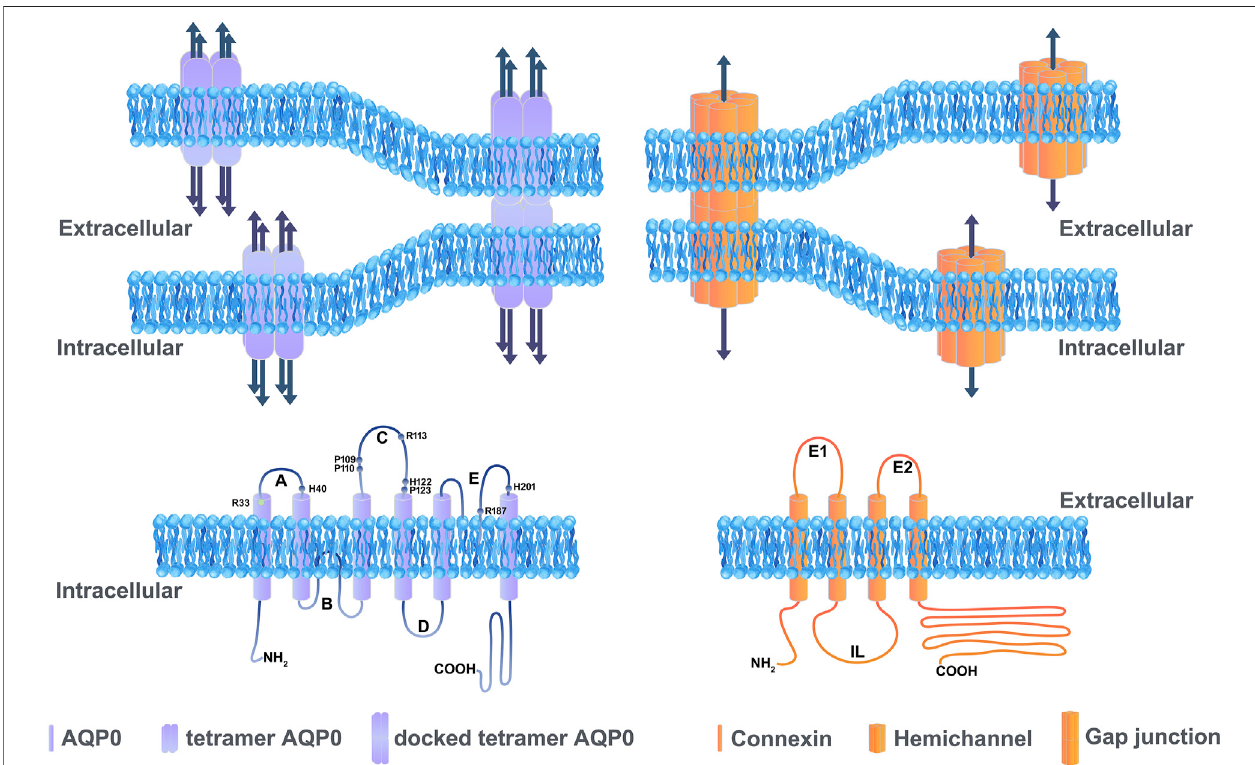
FIGURE 1 | Illustration showing the basic structure of channels formed by aquaporins and connexins. Aquaporins and connexins share similar membrane topologies consisting of transmembrane domains connected by extracellular and cytoplasmic loops; both the amino- and carboxy-termini are intracellular. An AQP0 monomer consists of six transmembrane α -helices and two half helices connected by fi ve loops. Each AQP monomer contains an independent water pore. AQP0 tetramers forms wavy thin junctions or square array junctions between adjacent cells. The dark blue arrow represents the pore which transports water (left upper panel). The amino acid residues (Arg33, Arg113, Arg187, His40, His112, His201, Pro109, Pro110, and Pro123) located in the extracellular loop domain involved in the celladhesionarelabeled(leftlowerpanel).Themembranetopologyofaconnexinconsistsoffourtransmembranedomains, twoextracellularloopsandonecytoplasmic loop (right lower panel). Connexin channels provide a pathway for the intracellular and intercellular exchange of ions, small metabolites, and second messengers (dark bluearrow).Ahemichannel(alsoknownasconnexons)isformedbysixconnexinsthatcontainsaporeinthecenter,andahemichanneldockwiththeotherhemichannel of adjacent cells to form a functional intercellular channel termed gap junction channel (right upper